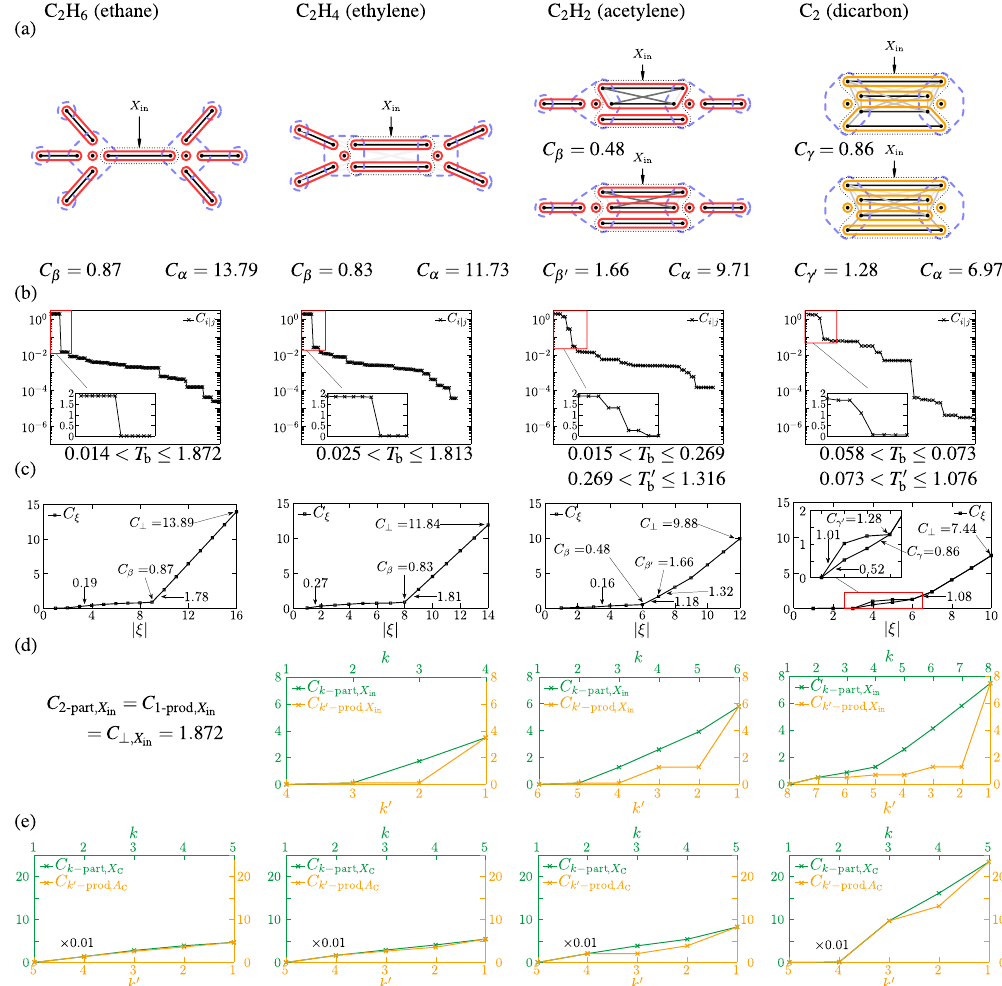
Figure 3. Partitioning and multipartite correlations for the C 2 H 2 x molecules. The same types of data are shown as in Fig.